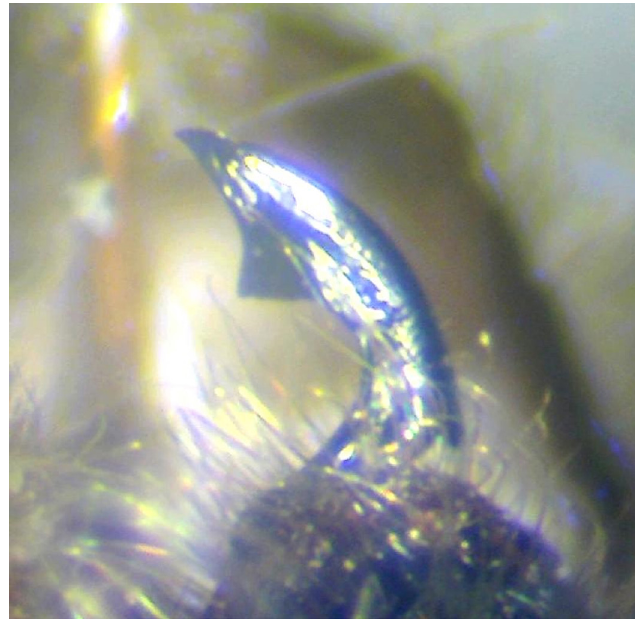
Fig. 20. Parusia almeria gen. et sp. nov.,